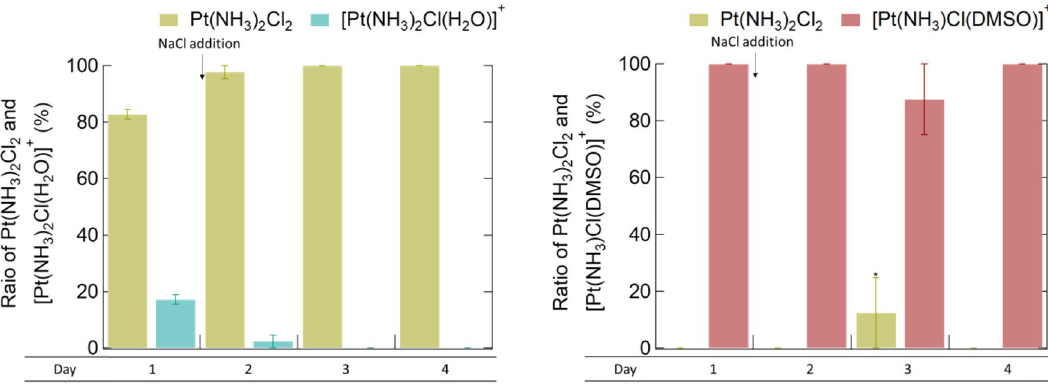
Figure 3. Ratio of Pt(NH 3 ) 2 Cl 2 and the substituted compounds after dissolution in 50 wt% TMG aq. or equimolar DMSO aq., followed by NaCl addition. *The peak of Pt(NH 3 ) 2 Cl 2 on day 3 in DMSO aq. was observed in only one of the three